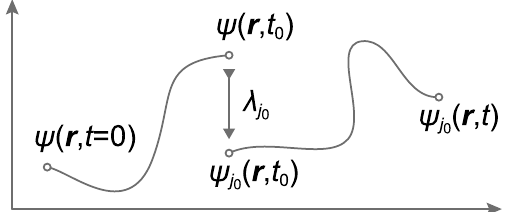
Figure 1. Von Neumann projection scheme: the quantum state at the moment of measuring the size of the ˆ A collapses to a randomly selected eigenfunction of this observable, ψ j observable is a random value on of this corresponding eigenvalue (cid:31) j 0 (the real number). The result is completely random and the measurement destroyed the state of �( r , t ) , which ’remembered’ its initial condition �( r , t = 0 ) and the system has any further memory on this state. The new evolution no longer remembers this state and begins with a completely randomly selected eigenfuncion of the observable ψ j 0 ( r , t 0 )